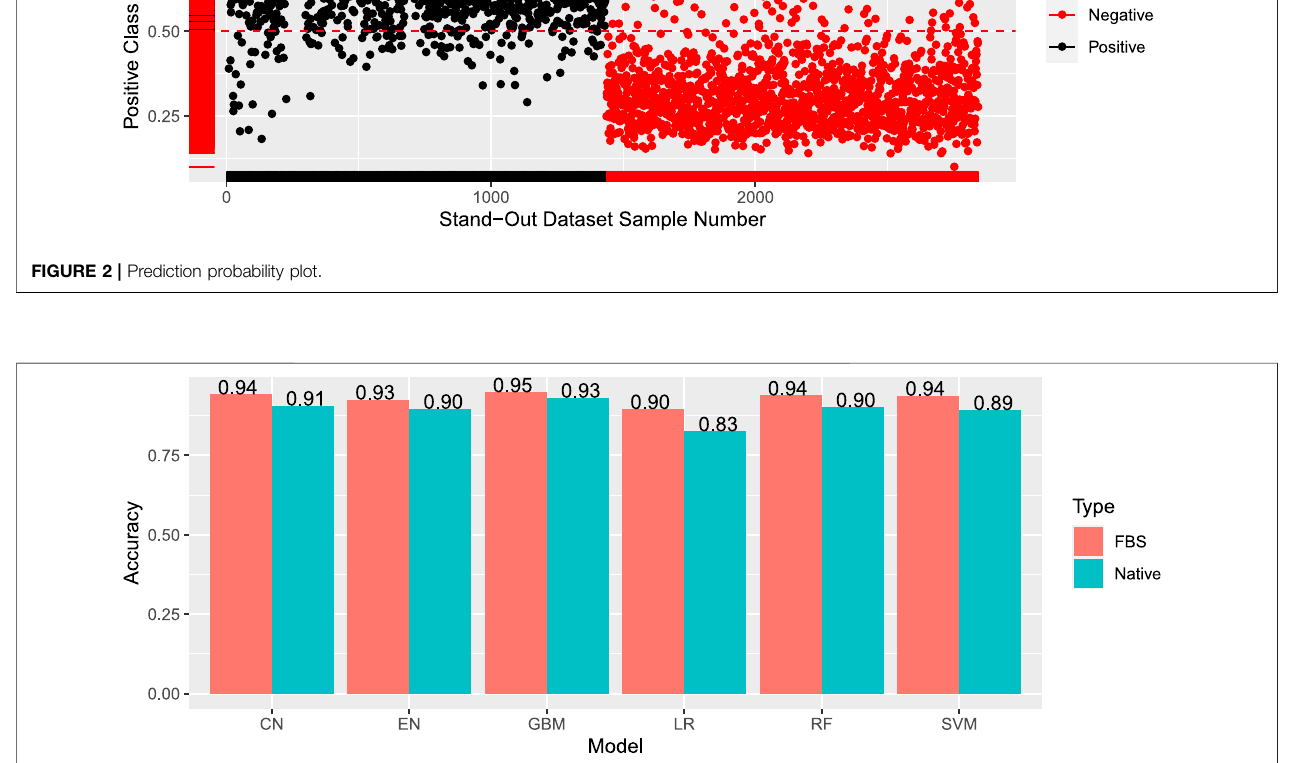
FIGURE 3 | Internal accuracies for all ML classi fi ers (EN, elastic net; LR, logistic regression; SVM, support vector machines; CN, convolution network; RF, random forest; GBM, gradient boosting machine; FSB, feature selection-based model) showing that GBM has the highest accuracy.